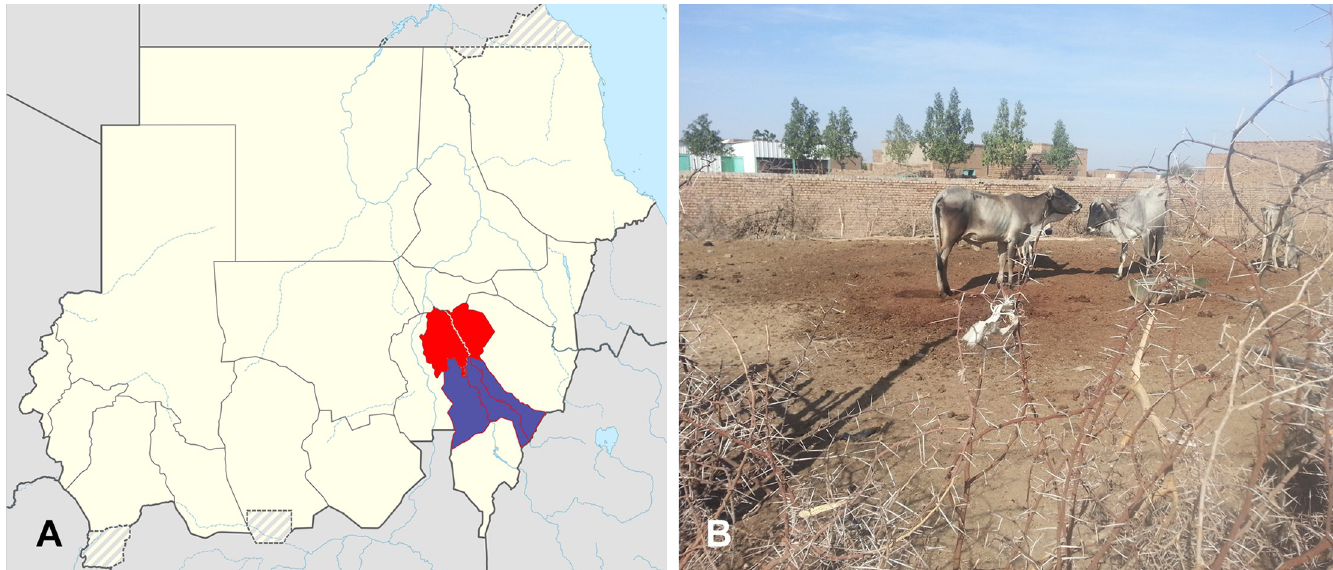
Fig 7. Sudan map, mycetoma endemic areas. A) Gezira State (Red), Sinnar State (Purple). B) Thorns and animal dung in an affected village in Gezira